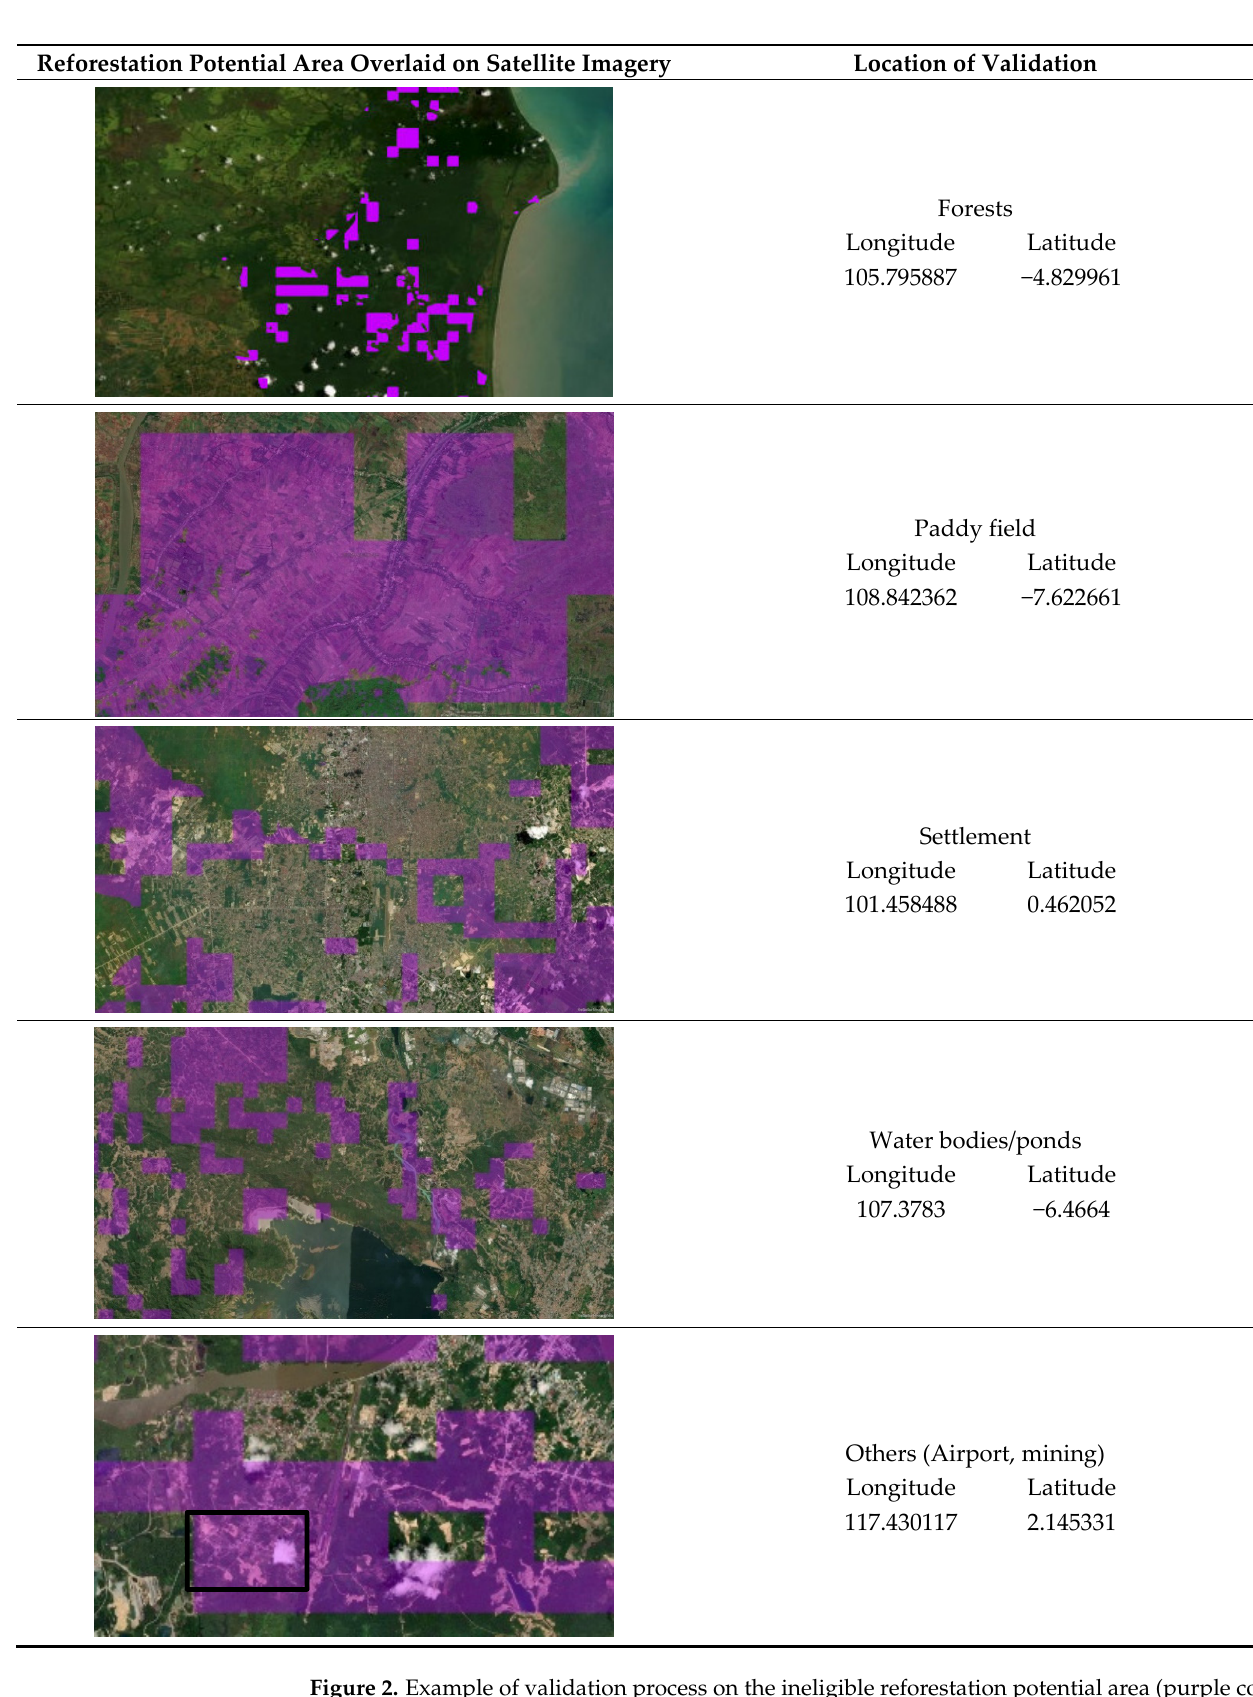
Figure 2. Example of validation process on the ineligible reforestation potential area (purple color) from [9] using Landsat imageries with 30m spatial